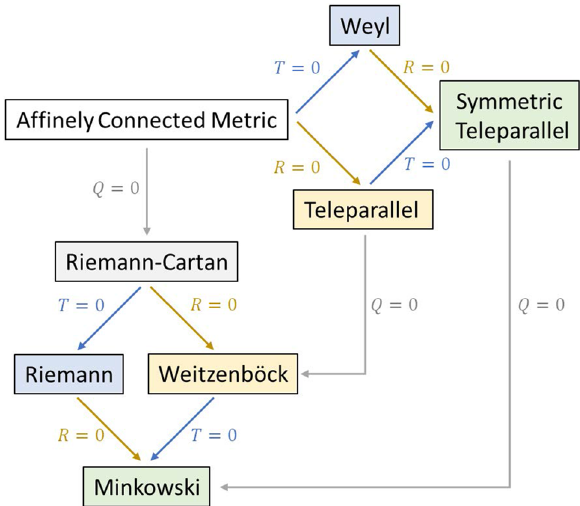
Fig. 1 Diagramofaffinelyconnectedmetricspacetimesillustratingall permutations of the non-metricity tensor Q abc , the Riemann curvature R a bcd and the torsion T a bc , where indices have been suppressed for presentation purposes. For more details on these spacetimes see Refs.